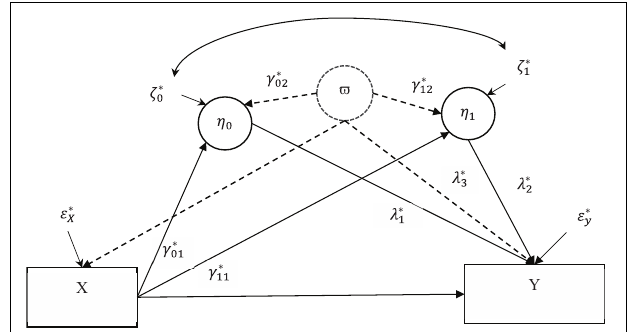
FIGURE 3 | A latent augmented LGCMM. The antecedent variable ( X ) was pain at 4 months after treatment. The two covarying mediators were the latent intercept ( η 0 = mean negative mood at 4 months) and slope ( η 1 = monthly rate of negative affect) for the repeated measures of negative affect. The outcome variable ( Y ) measures percent drinking days (PDD) at 16 months. A solid single-headed arrow shows the direct effect of a variable at the origin on the variable at the end of the arrow. A solid double-headed arrow shows covariance between the two residuals. The dashed circle shows the latent proxy variable (cid:36) and the dashed arrows show the confounder parameters modeling the effect of the latent proxy variable on the endogenous variables.